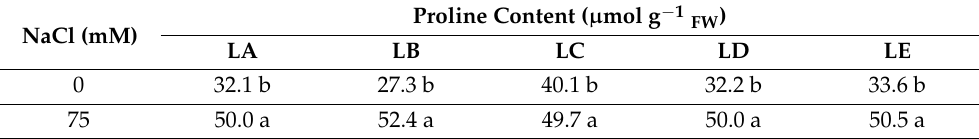
Table 3. Proline content of salt tolerant selected clones of five alfalfa lines measured after 30 days of growth on culture medium enriched with 0 and 75 mM NaCl. Data represent the average of 20